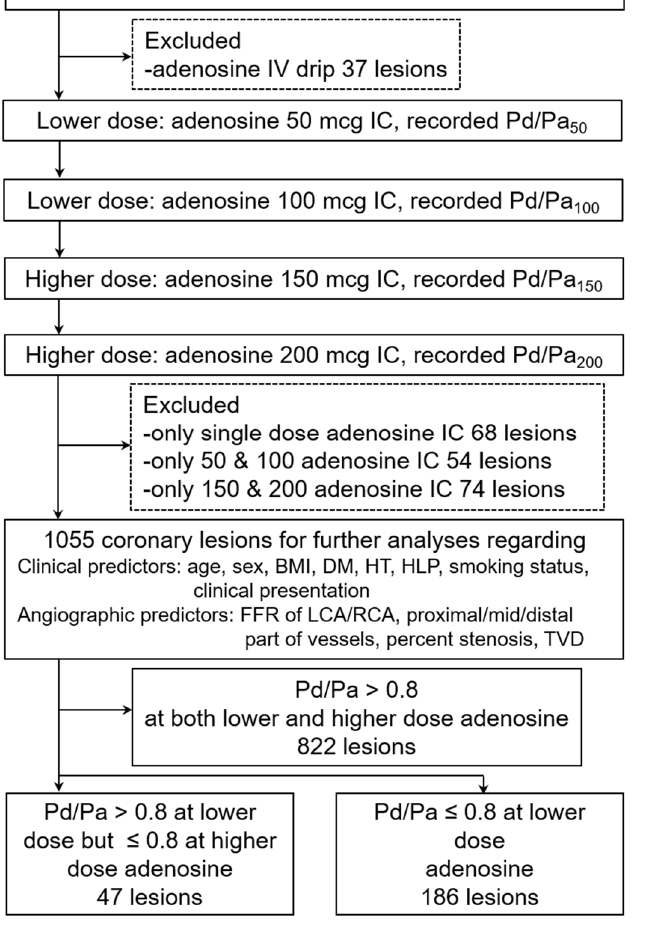
Figure 1. Study flow chart. FFR—fractional flow reserve; IV—intravenous; mcg—microgram; IC—intracoronary; Pd/Pa—ratio of pressure distal to coronary lesion divided by pressure of aorta; BMI—body mass index; DM—diabetes mellitus; HT—hypertension; HLP—hyperlipidemia; LCA—left coronary artery; RCA—right coronary artery; TVD—triple vessels coronary artery disease.